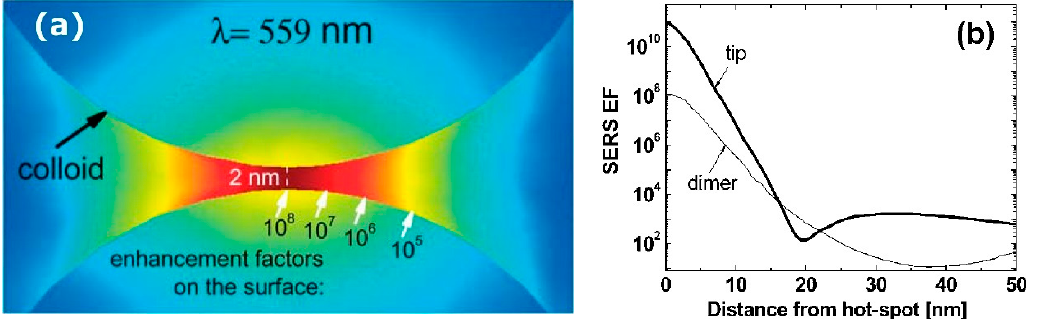
Figure 13. ( a ) G SERS distribution inside the 2 nm gap formed by two gold nanoparticles with a radius of 30 nm. The enhancement is calculated at the wavelength at which it reaches its maximum value. ( b ) Variation of G SERS along the (curved) surface of the nanoparticle (thin black line); the thick black line is not commented in this paper. Reproduced with permission from Etchegoin et al. [16].